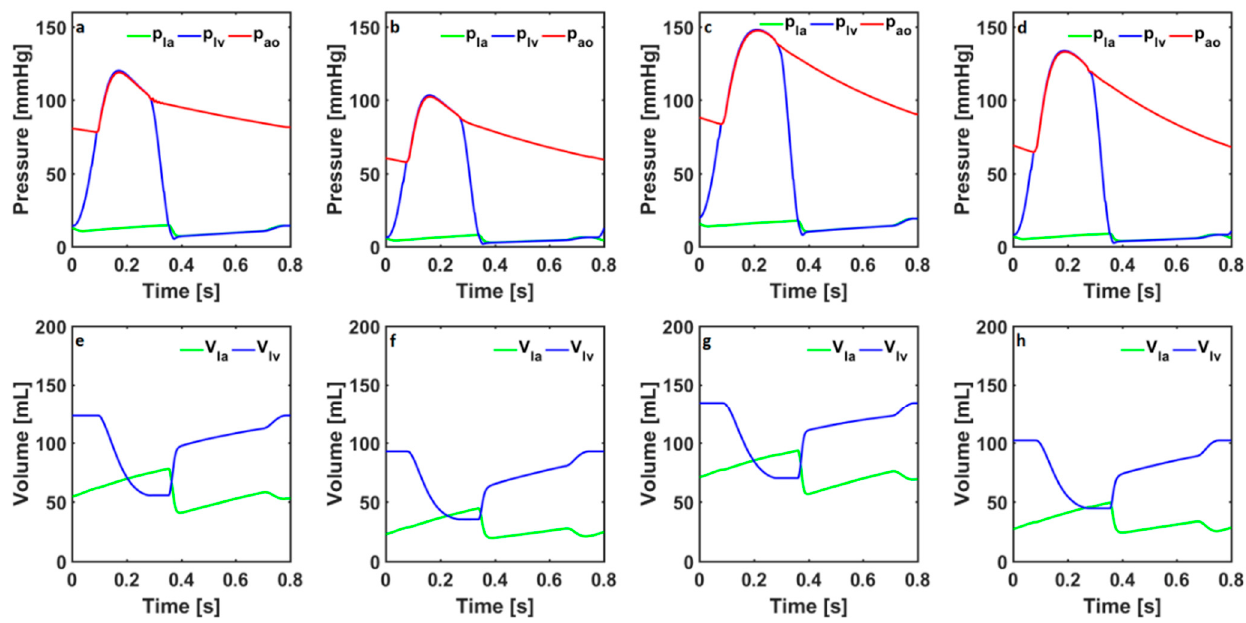
Figure 2. The left-atrial and left-ventricular pressures (p la , p lv ) and aortic pressure (p ao ) in the cardiovascular system models simulate healthy conditions in ( a ) adults and ( b ) children and coarctation of the aorta in ( c ) adults and ( d ) children. The left-atrial and left-ventricular volumes (V la , V lv ) in the cardiovascular system models simulate healthy conditions in ( e ) adults and ( f ) children and coarctation of the aorta in ( g ) adults and ( h ) children.